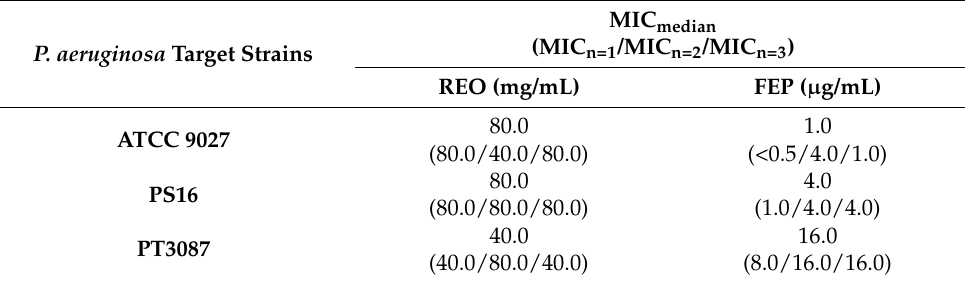
Table 4. MIC values of REO and FEP. MIC values are represented as the median of three independent